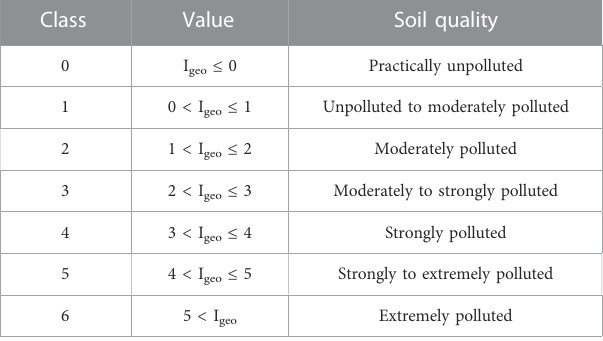
FIGURE 2 Concentrations of heavy metals in theleaches of mine tailings by acid solutions.